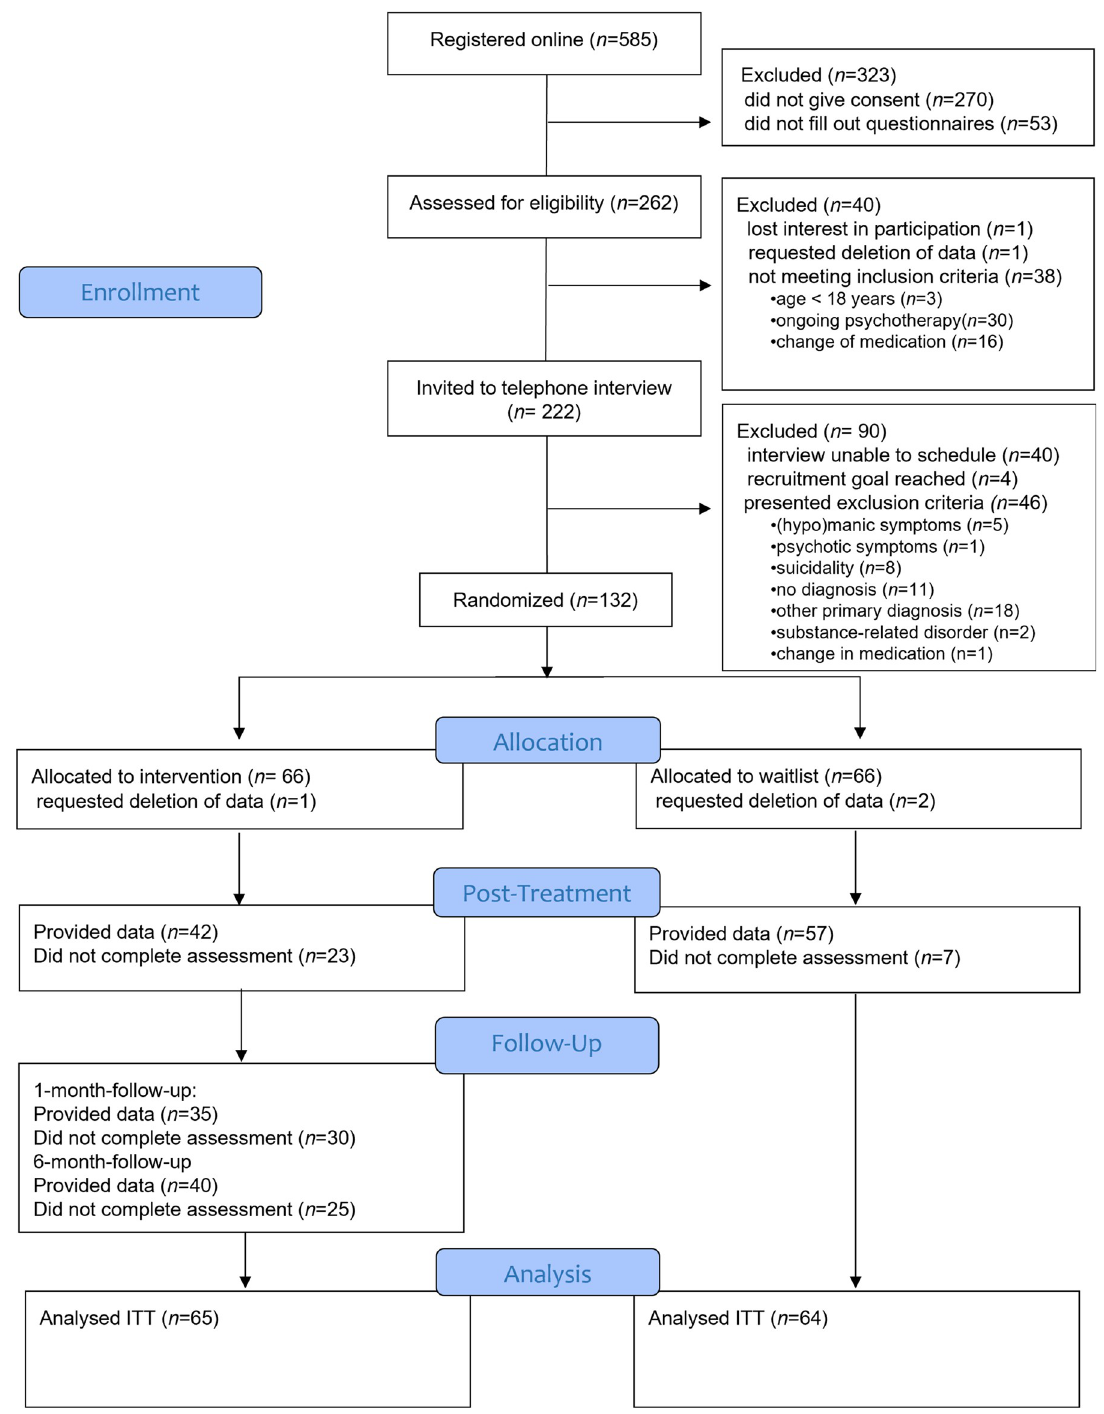
Fig 1. Consort flow chart. Note . Since this present study, which focuses on establishing efficacy, and a previously published study, which focuses on underlying mechanisms of change [28], are based on the same RCT, the participant flow charts of both studies are